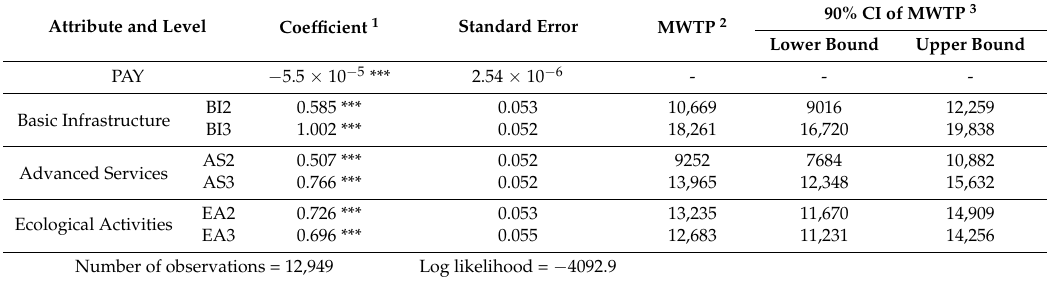
Table 4. Estimated results and MWTP (marginal willingness to pay) of visitors in